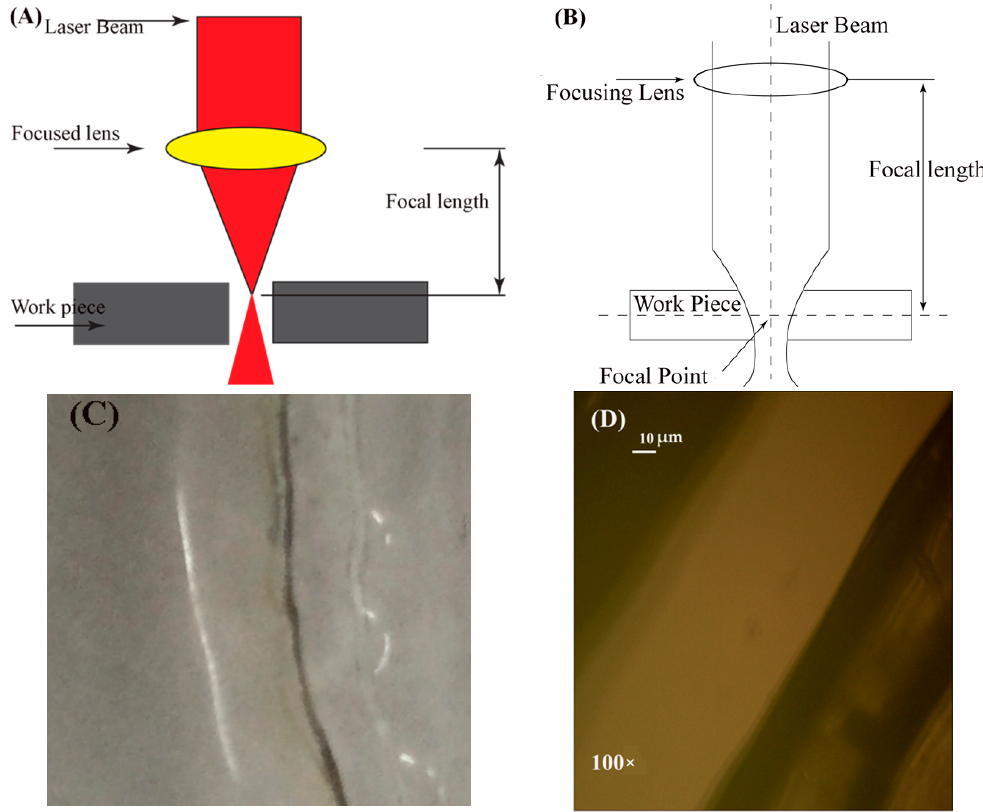
Figure 14. ( A , B ): Schematic representation of the focal point position/standoff distance in laser cutting, ( C ) Physical view of the cut part at more standoff distance, ( D ): Microscopic examination of cut part at high standoff distance.